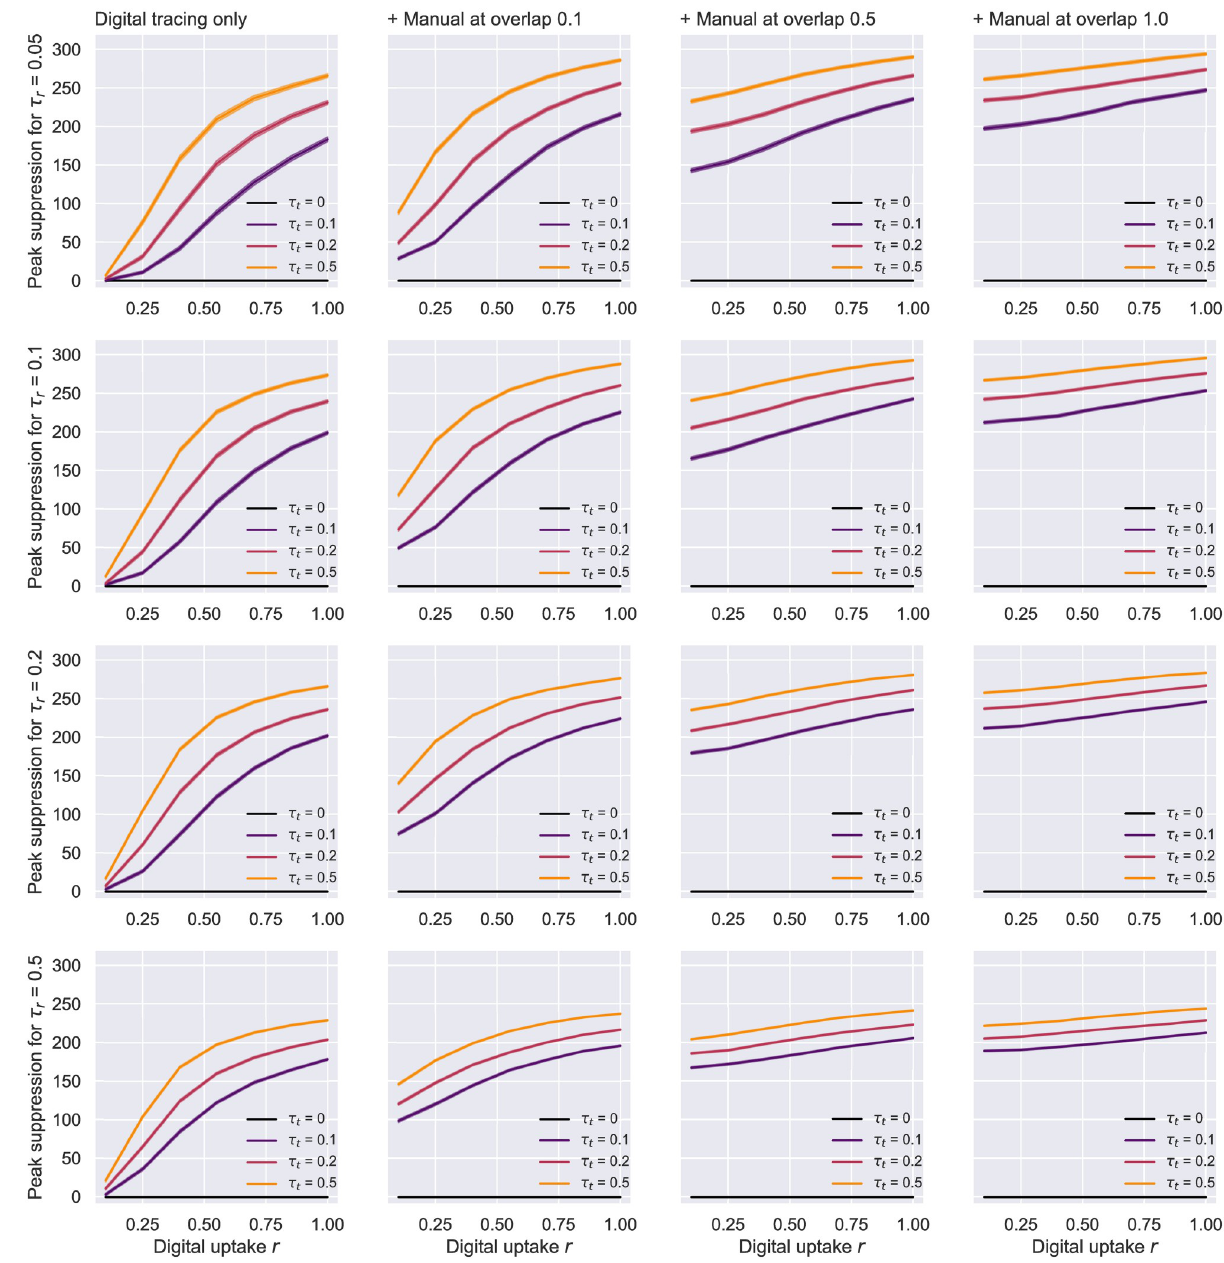
Fig 12. HK network—Uptake rate r against peak suppression. Suppression is difference in peak to no tracing, i.e. τ t = 0. The results here correspond to a Holme-Kim network with N = 1000, m = 10, p 4 = 0.2, p = 0.2, η = .001. On the left, we have a scenario in which only digital tracing was a conducted, whereas the next 3 columns represent simulations with a combination of digital tracing on a second network, and manual tracing over a third network with various overlaps: 0.1, 0.55, 1. The 95% confidence intervals are displayed. The case with no tracing ( τ t = 0) is colored in black.